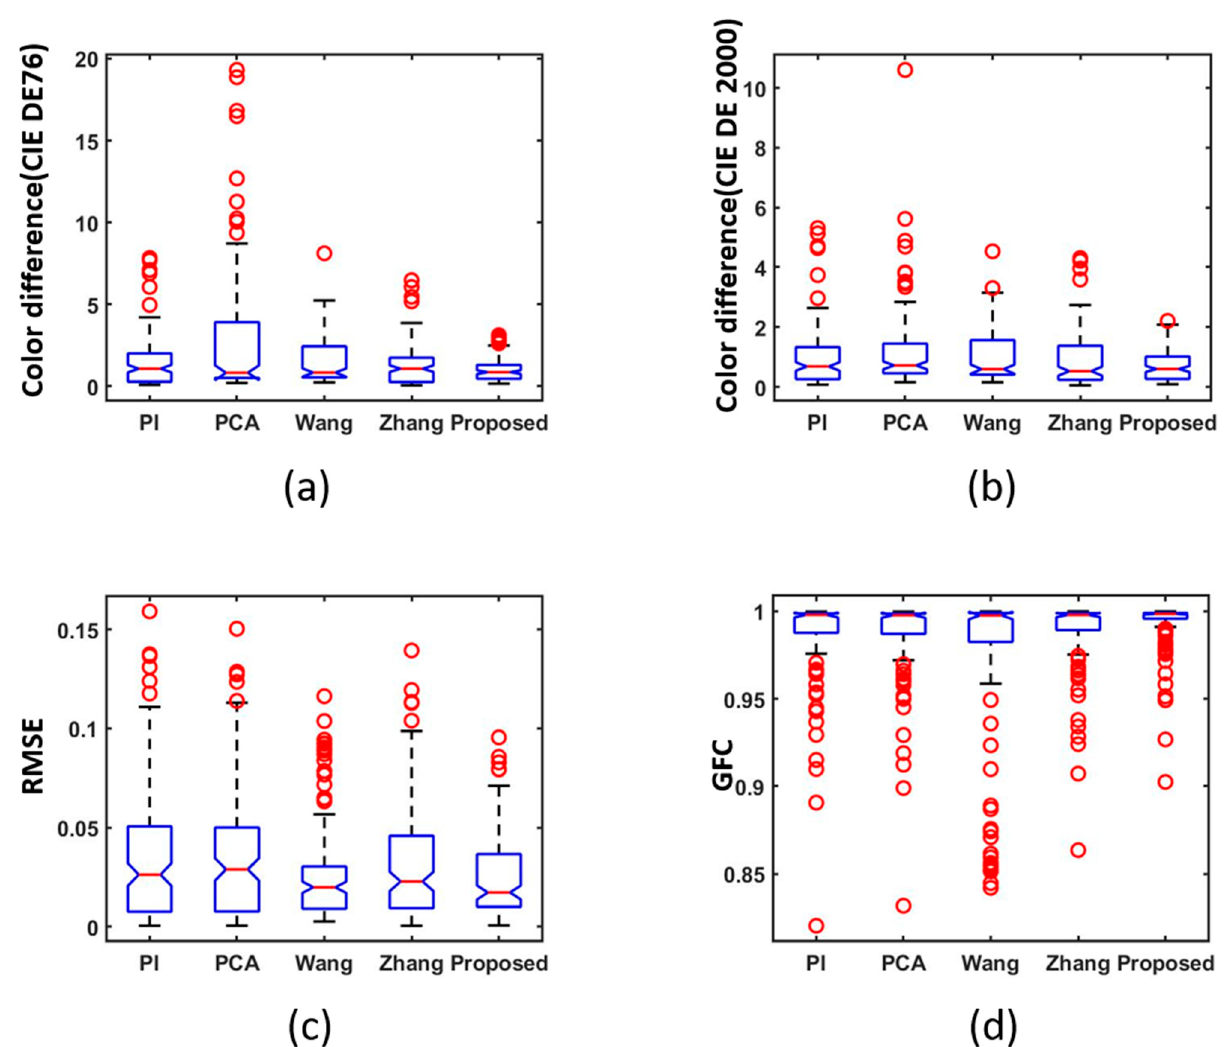
Figure 6. Boxplots of simulated experiment results: ( a ) CIEDE 1976 color difference, ( b ) CIE DE2000 color difference, ( c ) RMSE and ( d ) GFC.